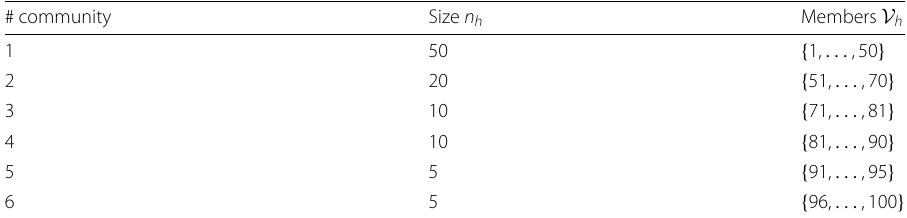
Table 2 Benchmark with exclusive community structures